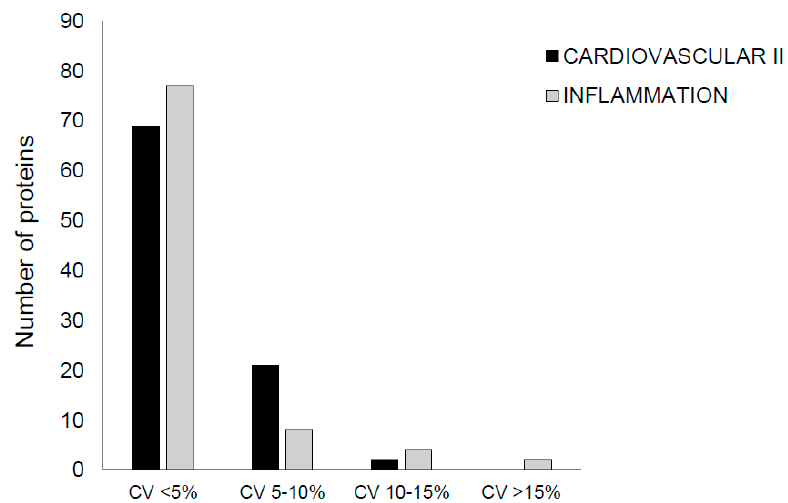
Figure 1. Intraassay %CV distribution. The number of proteins with %CV within defined intervals is indicated in case of Cardiovascular II and Inflammation panels. 3